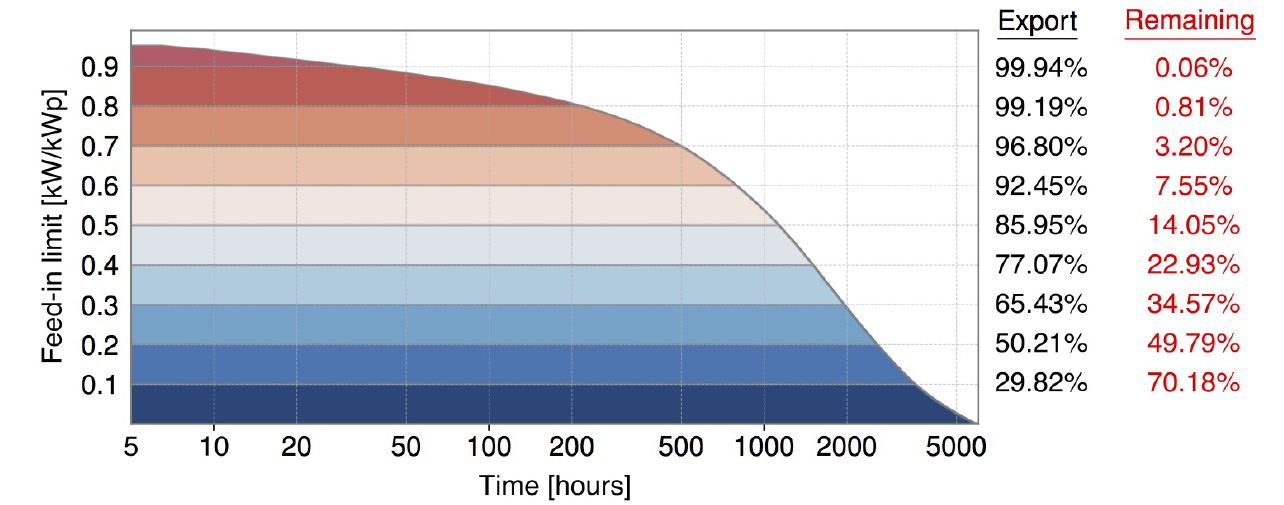
Figure 1. Annual load duration curves of PV generated electricity exported to the grid for 9 different feed-in limitations classes